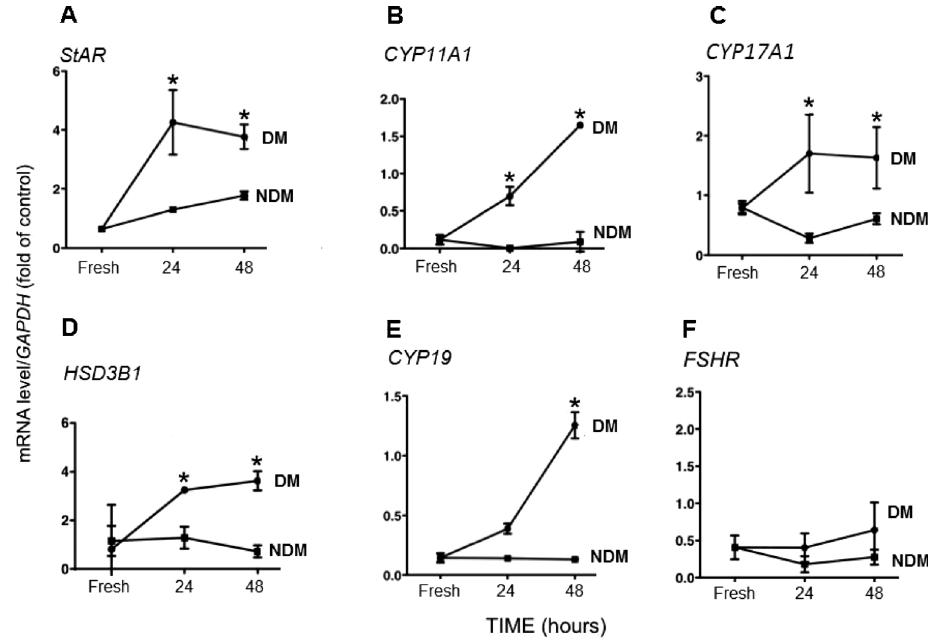
Figure 3. Semi-quantitative analysis of mRNA expression of steroidogenic acute regulatory protein ( StAR ), steroidogenic enzymes, and FSHR . Circles represent data for follicle wall sections (FWS) cultured in defined medium (DM) and squares represent data for FWS cultured in nondefined medium (NDM). A , Steroidogenic acute regulatory protein ( StAR ). B , Cholesterol side-chain cleavage A1 ( CYP11A1 ). C , Cytochrome P450 17A1 ( CYP17A1 ). D , 3 Beta-hydroxysteroid dehydrogenase 1 ( HSD3B1 ). E , Aromatase ( CYP19 ). F , Follicle-stimulating hormone receptor ( FSHR ). Data of fresh follicle mRNA were used as a control. Each transcript level of target genes was normalized on the basis of the glyceraldehyde-3-phosphate dehydrogenase ( GAPDH ) level. One-way ANOVA followed by the Bonferroni least-significant test were used to verify differences among NDM or DM data during the period of culture. Differences between NDM and DM groups for each time of culture were identified using the Student t -test. *P , 0.05, significantly different between culture periods and within group medium type.